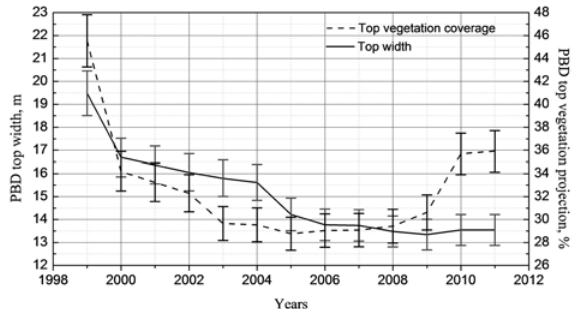
Fig. 4. Changes of PBD top width and vegetation coverage